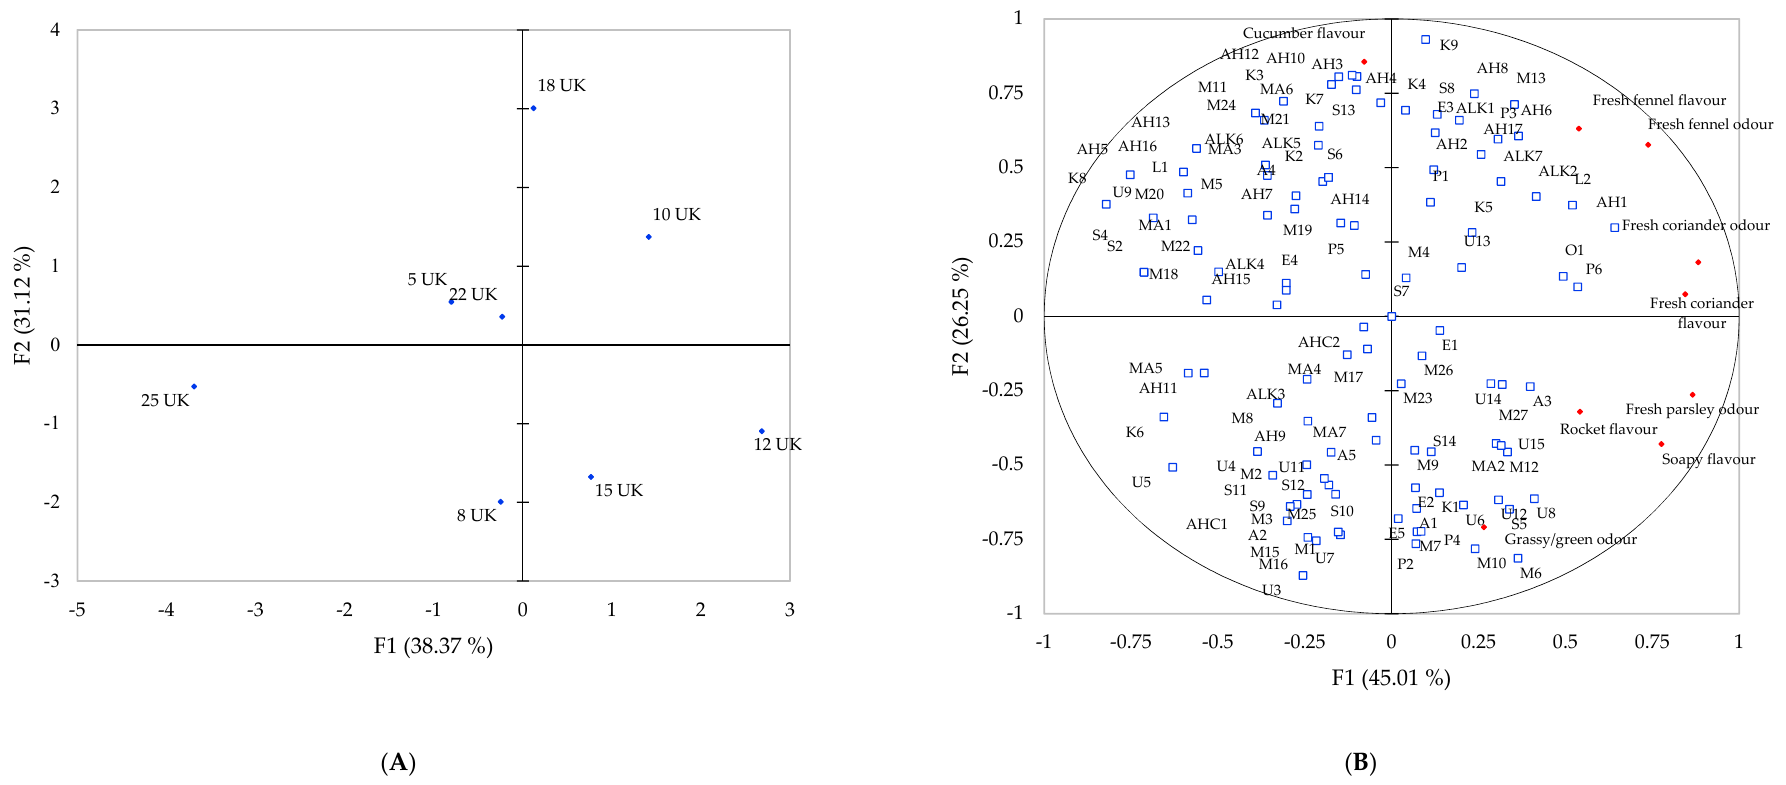
Figure 3. Principal component analysis of eight celery samples harvested in Spain 2019 showing correlations with volatile compounds and sensory attributes. ( A ) Projection of the samples; ( B ) Distribution of variables.